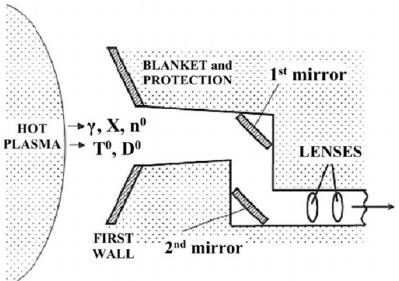
Figure 18. Schematic arrangement of the optical measurement components. Reprinted from Ref. [110]. Single-crystalline materials (Rh and Mo) have demonstrated good optical